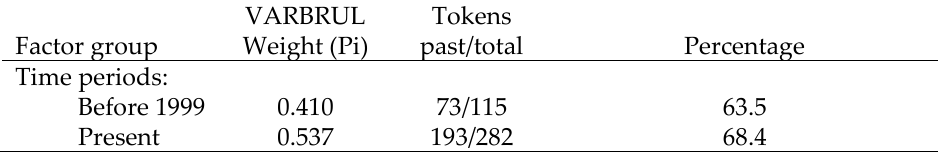
Table 3. Eliminated factor groups that does not affect tense choice VARBRUL Factor group Time